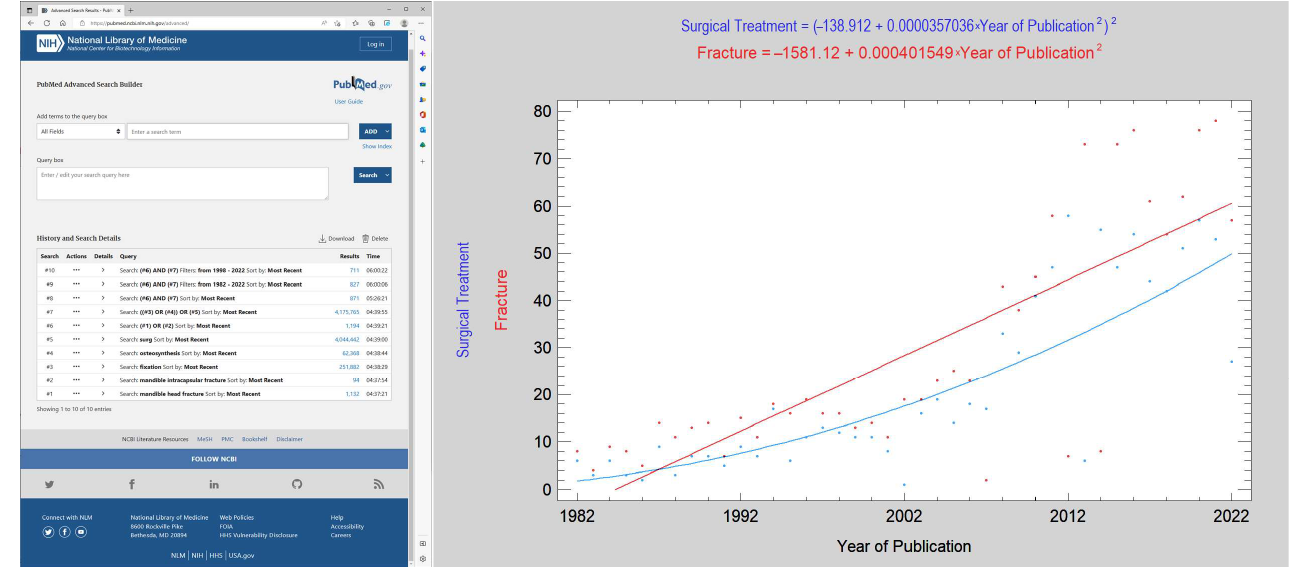
Figure 8. Annual number of publications on fractures of the mandibular head (Fracture) and surgical treatment of fractures of the mandibular head (Surgical Treatment). An attempt to explain the increasing incidence of mandibular head fracture diagnosis. The panel on the left shows how publications on mandibular head fractures and surgical treatment were sought. It seems that the possibilities of surgical treatment of these fractures have a greater ability to diagnose them.